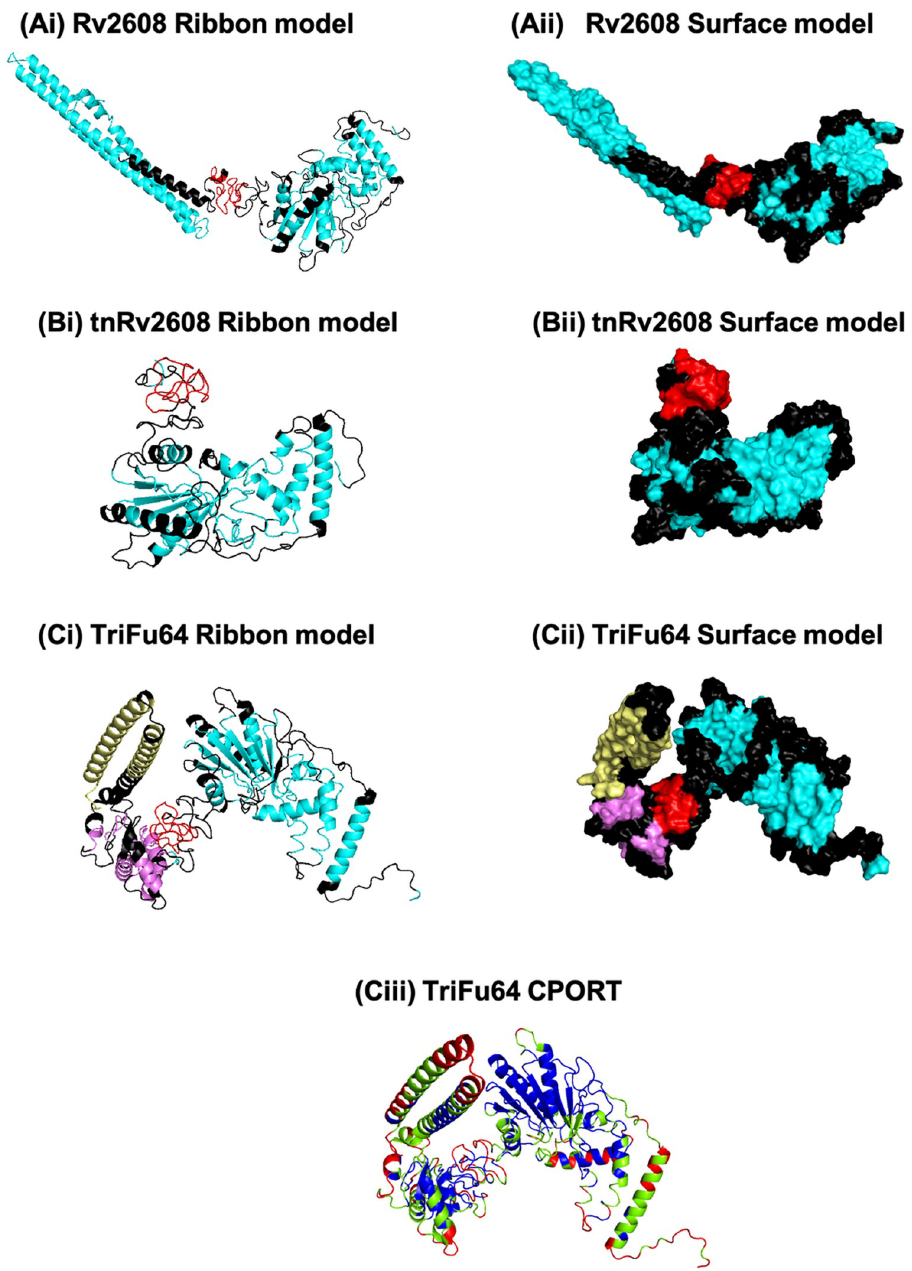
Fig 7. Ribbon and surface models of Rv2608 (Ai and Aii), tnRv2608 (Bi and Bii) and TriFu64 (Ci and Cii). Black color depicts B-cell epitopic regions. Yellow, pink and turquoise depict non-epitopic regions of Rv1793, Rv2628 and tnRv2608, respectively, while the red color indicates the highly antigenic MPTR motif of Rv2608. CPORT analysis structure of TriFu64 (Ciii) shows the solvent accessible (red), the supporting (green) and the non-supporting (blue)